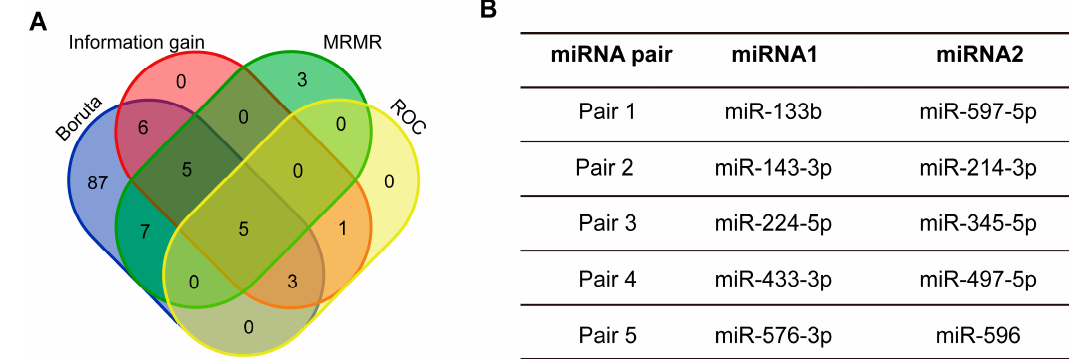
Figure 3. Identification of five miRNA pairs for model development using feature selection methods. ( A ) Venn diagram of overlapping miRNA pairs among four sets filtered by ROC, information gain, maximum relevancy minimum redundancy (MRMR), and Boruta algorithms. The numerical values depicted in the diagram represent the overlapping miRNA quantities among different algorithms; ( B ) Detailed information of the five miRNA pairs.